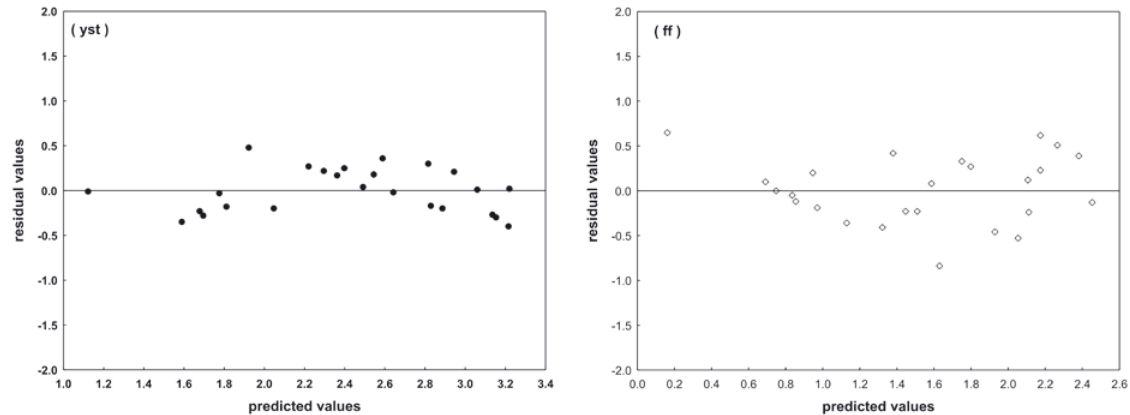
Figure 2. Graphical representation of residuals values FA versus predicted FA given by Eqs. 3 yst and 3 ff .